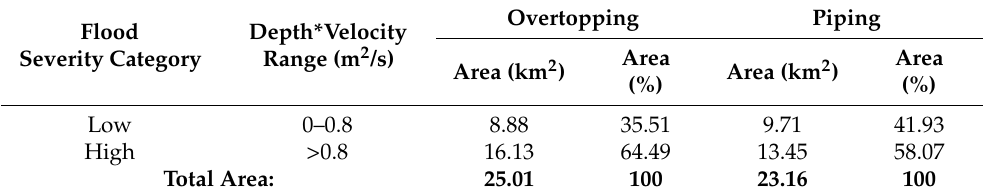
Figure 20. Flood hazard maps for the piping dam failure scenario (second classification approach). Table 11. Flood severity classes for the product of water depth and velocity and the inundated area per class (second classification approach).